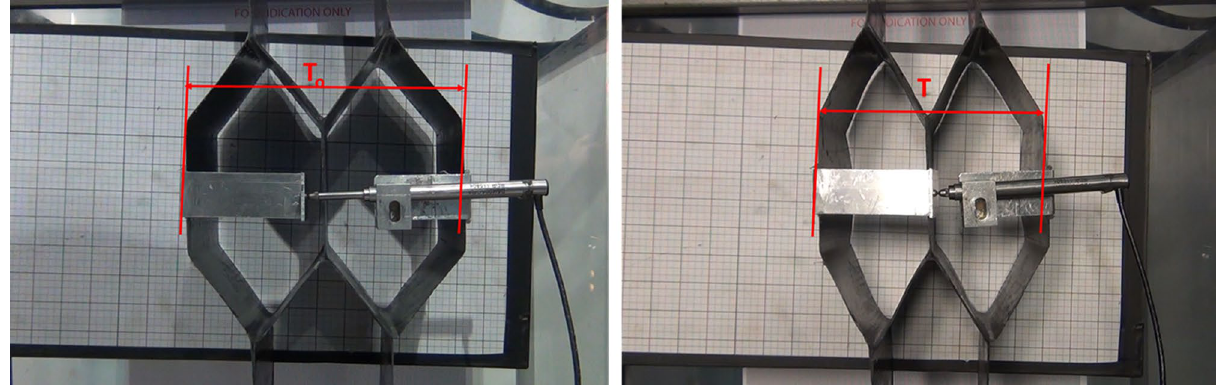
Figure 14. The start (left) and end (right) positions of tensile test for the honeycomb structure.